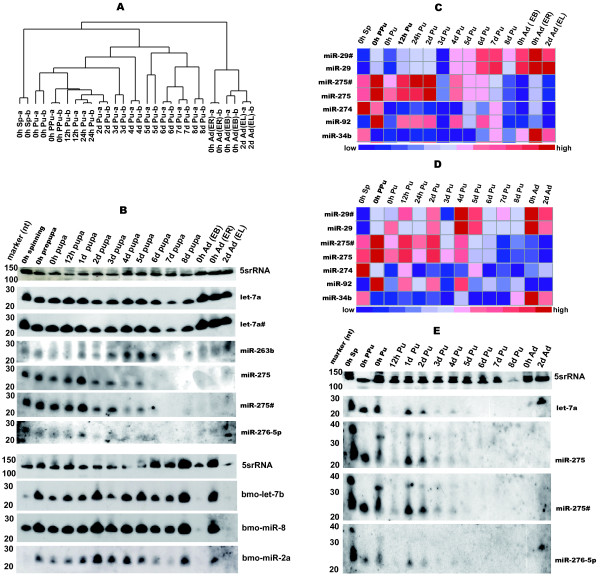
Profiling of miRNA expression during pupal metamorphosis. (A) Developmental time-points were grouped using the hierarchical clustering method and gene sets from Additional file 9. Gene names and quantitative miRNA expression levels are presented in Additional file 9. (B) Northern blotting analysis of specific miRNAs in females. (C) Stage-regulated miRNAs in females. (D) Stage-regulated miRNAs in males. (E) Northern blotting analysis of specific miRNAs in males. Northern blots were exposed for different times, and thus the intensities of signals on one Northern blot cannot be directly compared to those from others. A probe against 5srRNA was hybridized to respective blots for comparison.